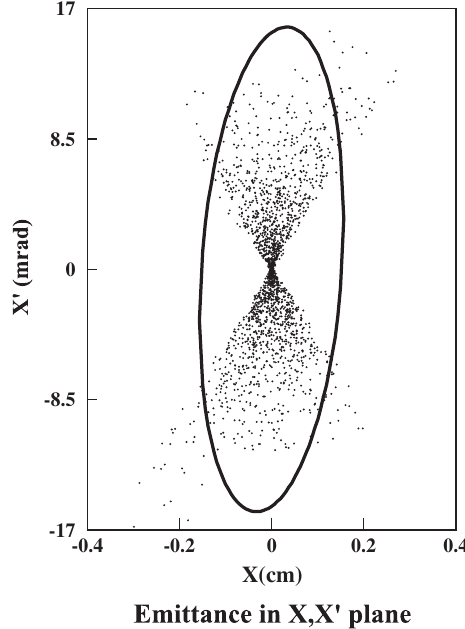
FIG. 8. Phase space projection at crossover ( (cid:1) ¼ 40 mrad